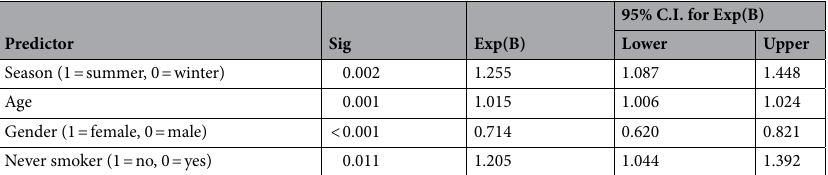
Table 4. Binary logistic multivariable regression analysis outcomes for the association between influenza (winter) season, participant characteristics and the detection of one or more lung nodules ≥ 30 mm 3 (~ 3 mm in diameter). Sig. p value, Exp(B) odds ratio, C.I. 95% confidence interval.